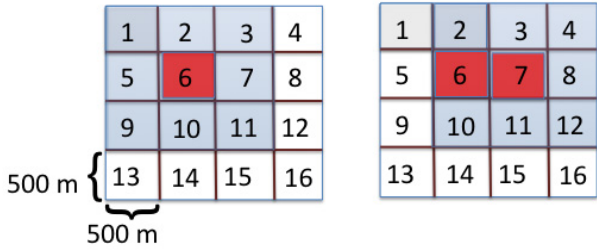
Fig. 3. Illustration of MODIS aerosol cloud mask spatial variabil- ity test. The algorithm identifies a set of 3 × 3 0.5km pixels and calculates standard deviation of the reflectance of those 9 pixels. If the standard deviation exceeds a designated value, the center pixel (pixel 6) is designated “cloudy” (denoted by shaded red in the fig- ure). Then the algorithm moves one column to the right and tests the next set of 3 × 3 pixels to determine if pixel 7 is “cloudy”.